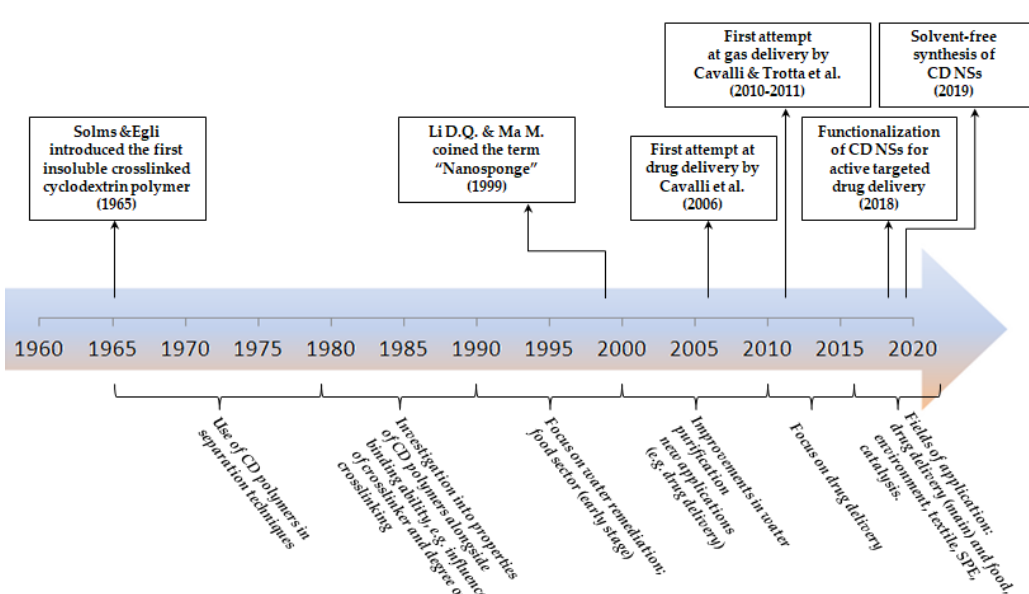
Figure 4. Timeline of the historical development of cyclodextrin-based nanosponges.